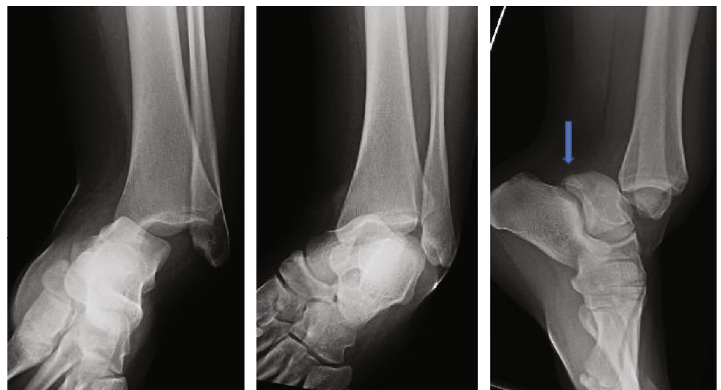
Figure 2: AP, lateral, and mortise radiograph demonstrating posteromedial ankle dislocation. The arrow on lateral view points towards double density over posterior talus representing displaced os